Question: What does this figure show? Answer in one sentence.
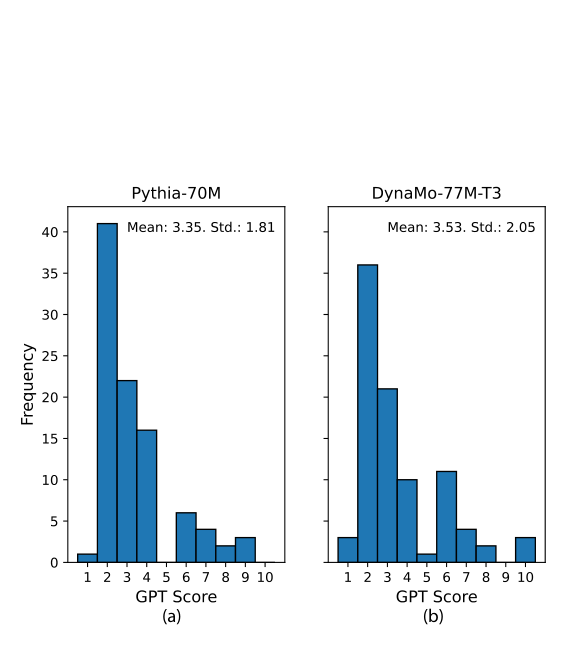
Answer: Histograms of GPT scores for single-mode evalu- ations on the sentence-completion benchmark for (a) Pythia- 70M and (b) DynaMo-77M-T3 (ϵb = 1.0). GPT-3.5 is used as the judge.